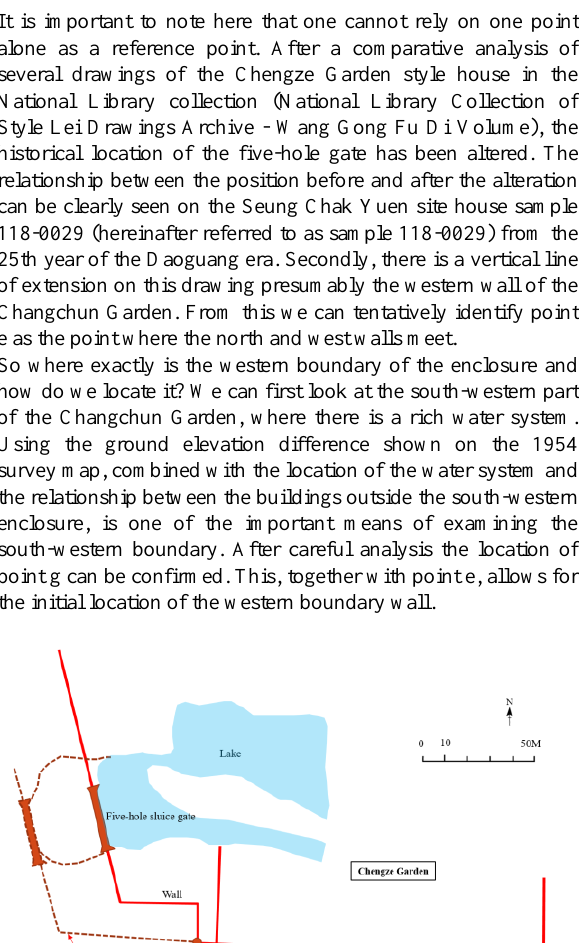
Figure 3. Complete analysis of the northern wall boundary of the Changchun Garden.